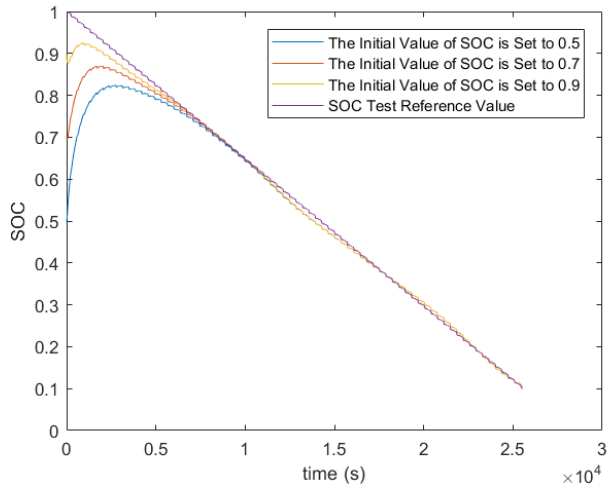
Figure 8. Convergence effect under the wrong initial value of SOC.